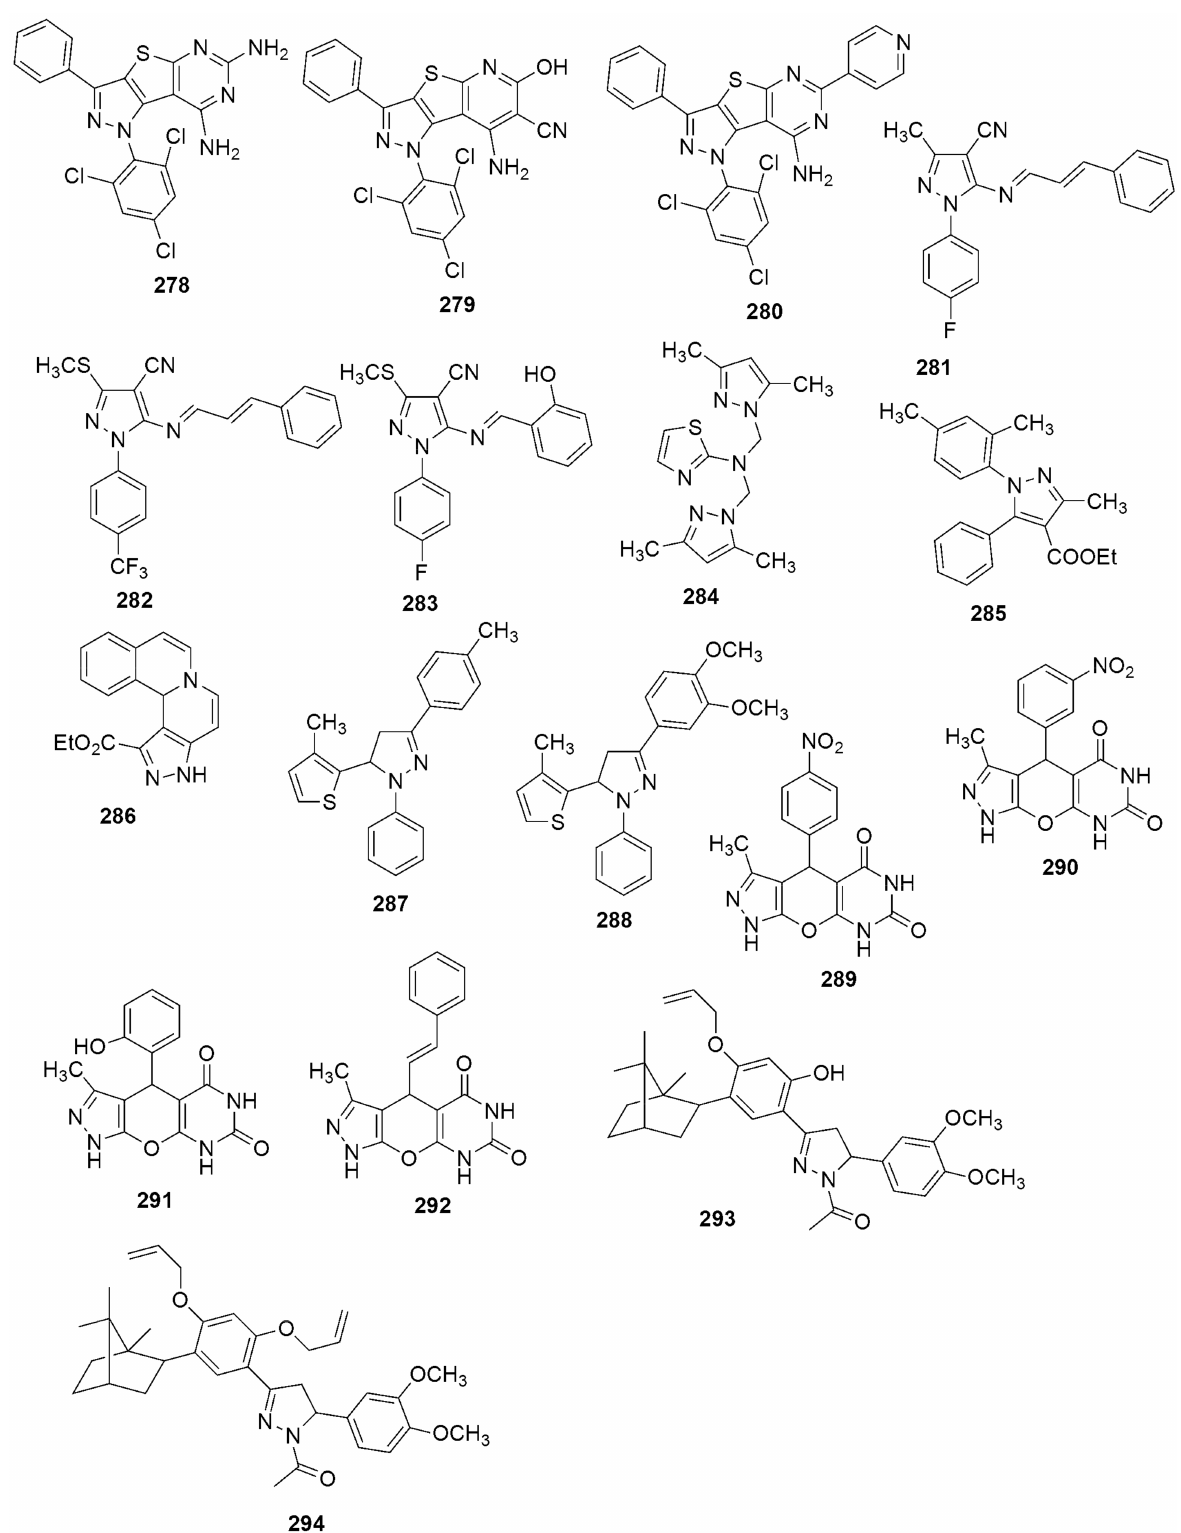
Figure 16. Structures of pyrazole hybrids with antioxidant